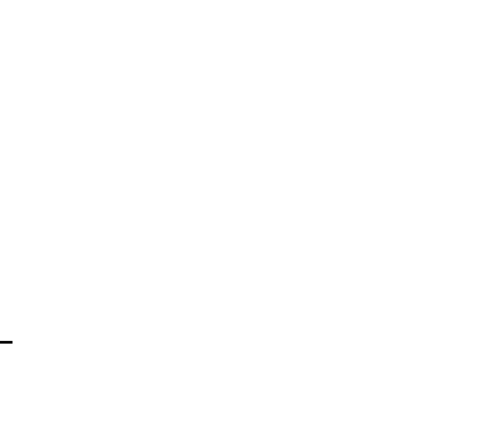
Figure 4. Effect of L-proline on L-asparaginase activity by Penicillium cerradense cultivated for 4 days at 30 °C. The results are presented as mean of enzyme activities with standard deviation for each run (n = 9). *9% ≠ 3% and 7% of the proline concentration ( p < 0.05). 7% vs 9% ( p = 0.0004); 3% vs 9% ( p <